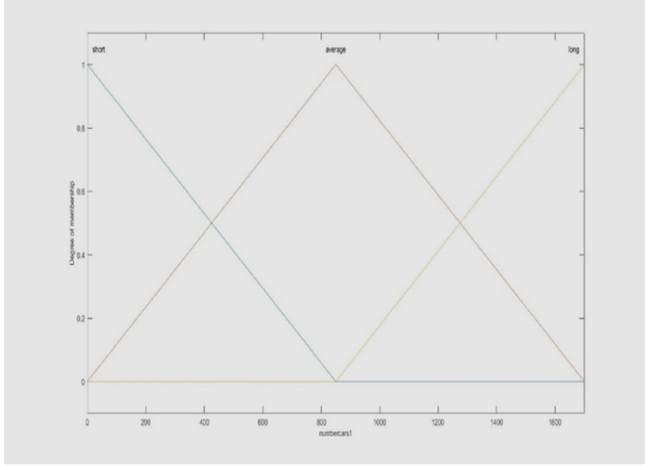
Figure 6. First input to fuzzy controller for junction 2 with three linguistic values.